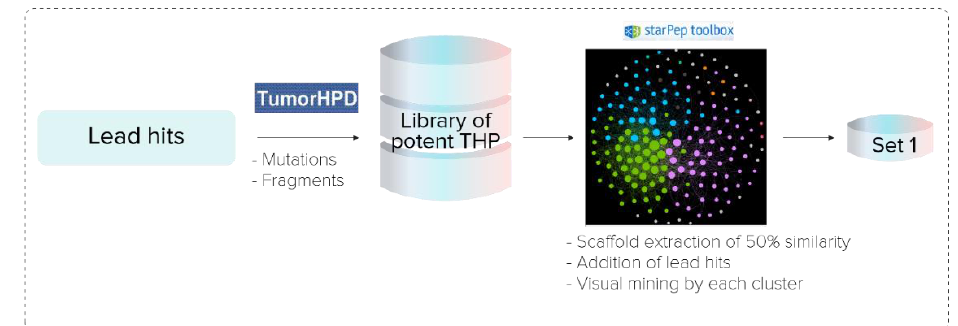
Figure 3. Procedure to optimize tumor-homing activity of lead